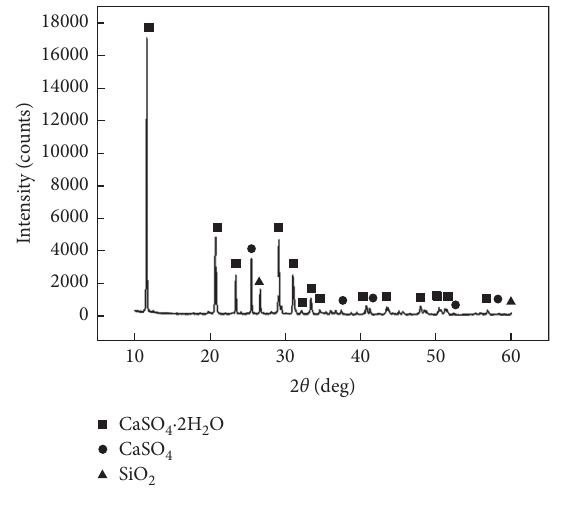
Figure 1: XRD pattern of gypsum rock. Table 1: Mineralogical composition of gypsum rock. Mineral Composition of mineral